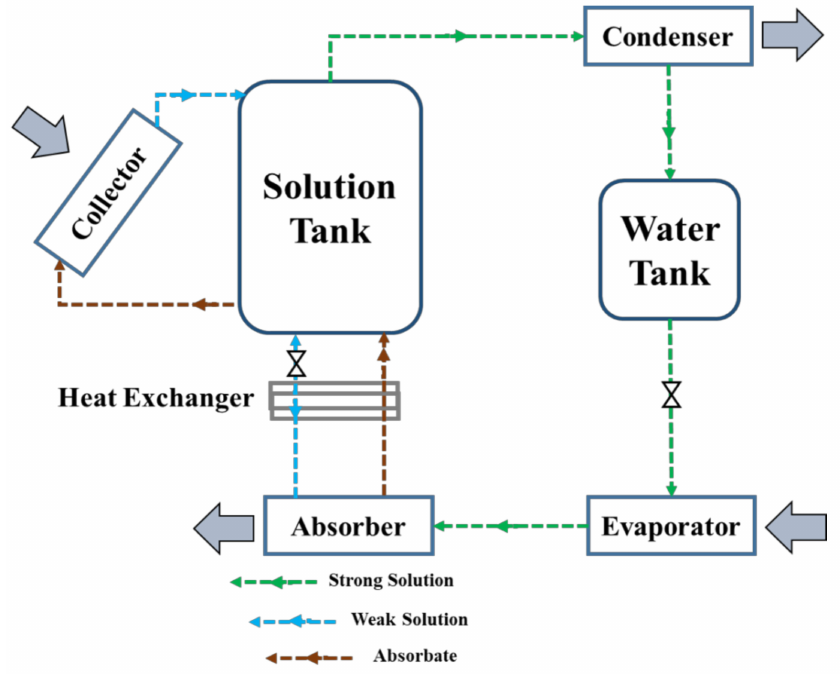
Figure 13. SPAR integrated with the storage system